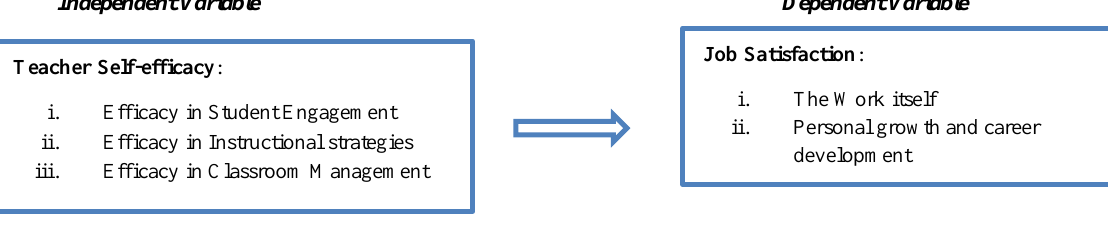
Figure 1: The conceptual framework depicts the correlation between the independent and dependent variables in which teacher self-efficacy affects job satisfaction; Source: Tschannen-Moran & Woolfolk (2001); Abun, et.al (2021).